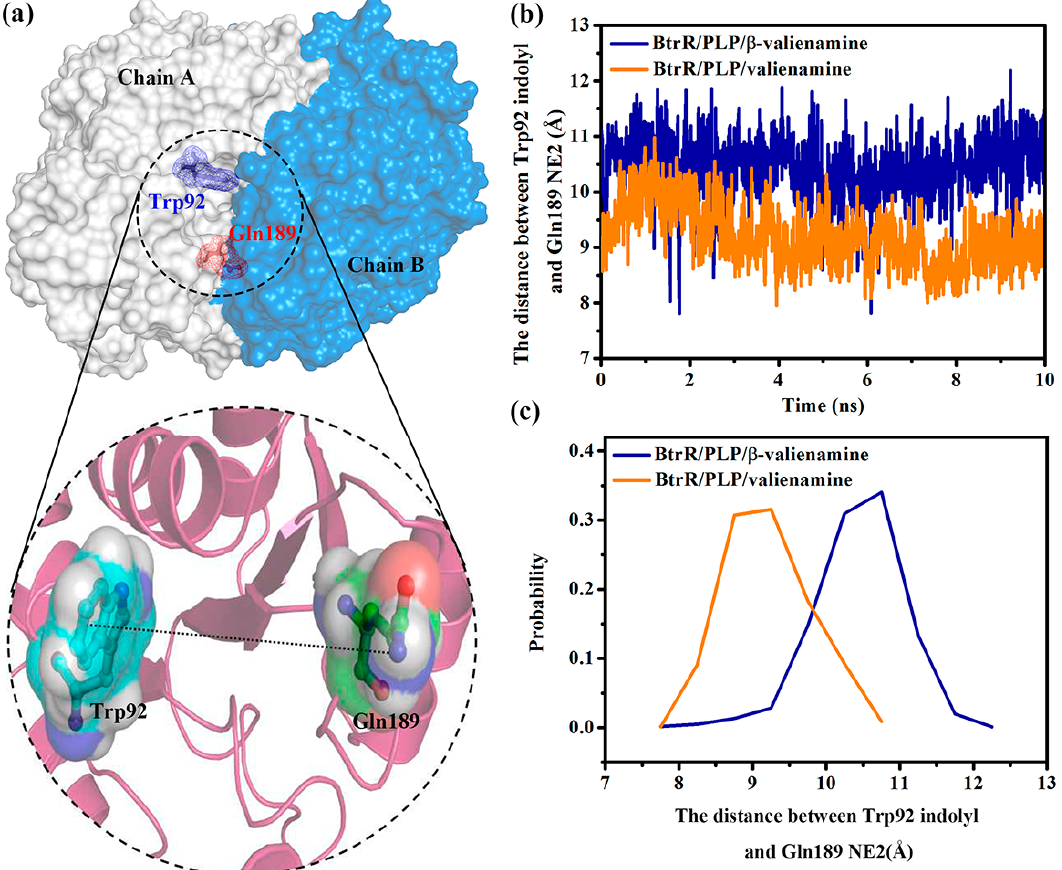
Figure 10. ( a ) The position of Trp92 and Gln189 in the BtrR channel. ( b ) The distance of distance between Trp92 indole group and Gln189 NE2 during the dissociation process. ( c ) Distribution probability of distance between the Trp92 indole group and Gln189 NE2.